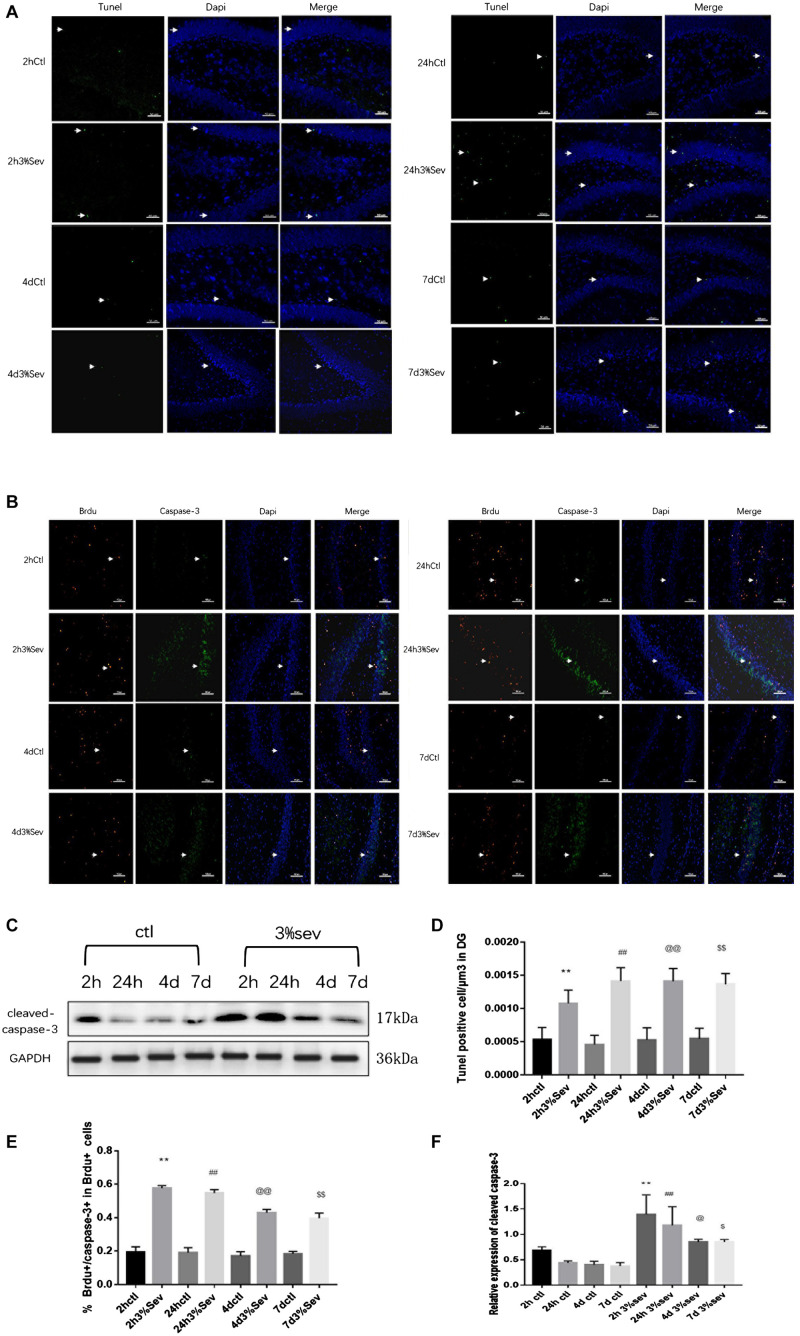
(A) Sevoflurane increased TUNEL expression in DG region 2 h, 24 h, 4 days, and 7 days after anesthesia. Scale bar = 50 μm. (B) BrdU (red) co-localization with caspase-3 (green) presented the apoptotic late progenitor cells 2 h, 24 h, 4 days, and 7 days in sevoflurane and control groups. Scale bar = 100 μm. (C) Sevoflurane increased cleaved caspase-3 expression in DG region 2 h, 24 h, 4 days, and 7 days after anesthesia. (D) Quantification of TUNEL positive cells/μm3 in DG region. (E) Quantification percentage of BrdU+/caspase-3+ in BrdU+ cells. (F) Quantification of cleaved caspase-3. n = 3. Values are presented as mean ± SD; **P < 0.01 compared with the 2-h control group, ##P < 0.01 compared with the 24-h control group, @P < 0.05 compared with the 4 days control group, @@P < 0.01 compared with the 4 days control group, $P < 0.05 compared with the 7 days control group, $$P < 0.01 compared with the 7 days control group.